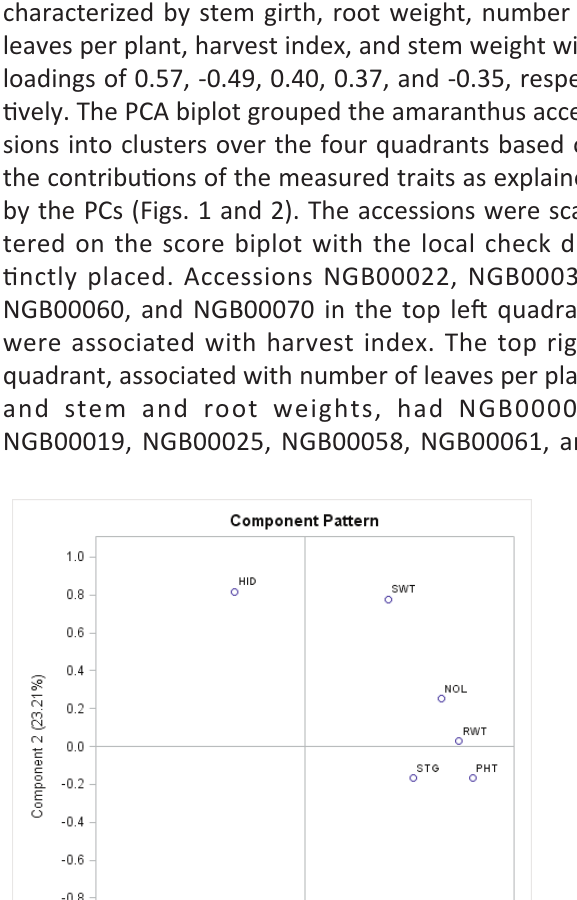
Re* and ** significant at 5 and 1% probabilities respectively.